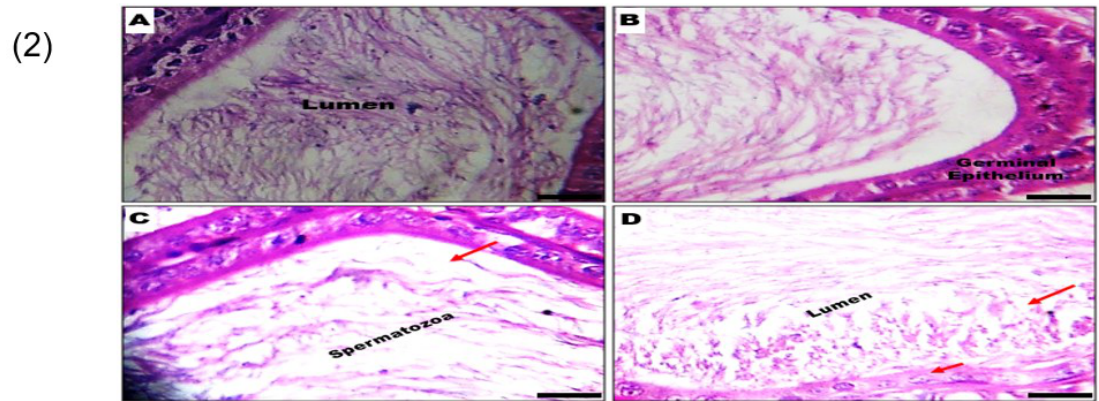
Figure 4. Representative photomicrographs of the epididymis from control and CSC-treated rats. ( 1 ) Germinal epithelium (GE) appears normal, and there was an abundance of spermatozoa (S) in the lumina (L) of the epididymal duct in ( A ) Control and ( B ) GSC 100-mg / kg groups, while treatment with ( C ) GSC 200 mg / kg and ( D ) GSC 400 mg / kg revealed mild depletion of L content and extravasation of GE in the epididymis (M × 200); ( 2 ) ( A ) Control and ( B ) GSC 100-mg / kg groups showed normal-looking germinal epithelium (GE) and abundance of spermatozoa (S) in the lumina (L) of the epididymal duct, while treatment with ( C ) GSC 200 mg / kg and ( D ) GSC 400 mg / kg revealed mild depletion of lumina content and chromatolytic changes in the GE (arrowed) (M × 400).